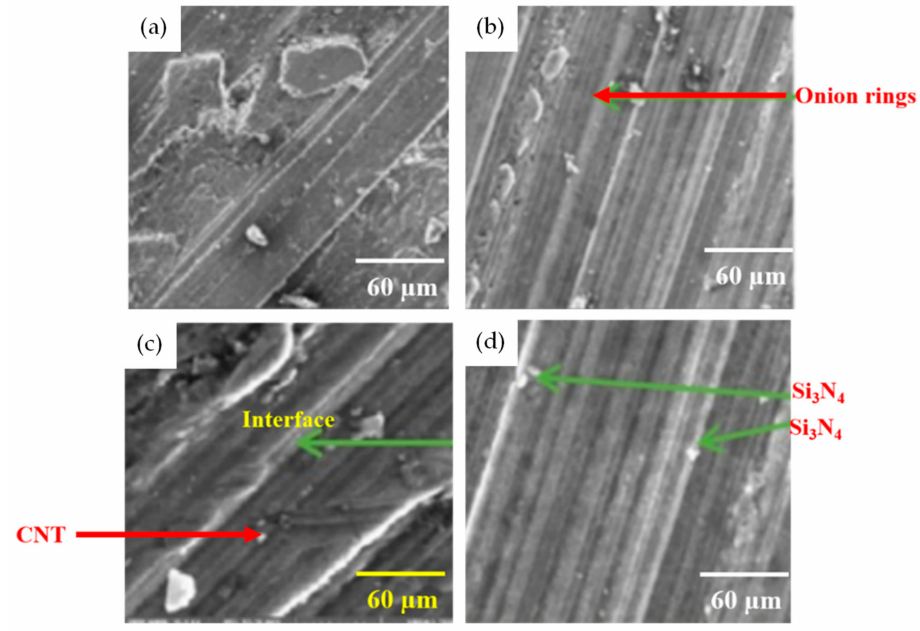
Figure 11. SEM images of specimens after FWTPET + FSP technique: ( a ) sample 1 (1000 rpm tool rotational speed); ( b ) sample 7 (1400 rpm tool rotational speed); ( c ) sample 16 (1600 rpm tool rotational speed); ( d ) sample 21 (1800 rpm tool rotational